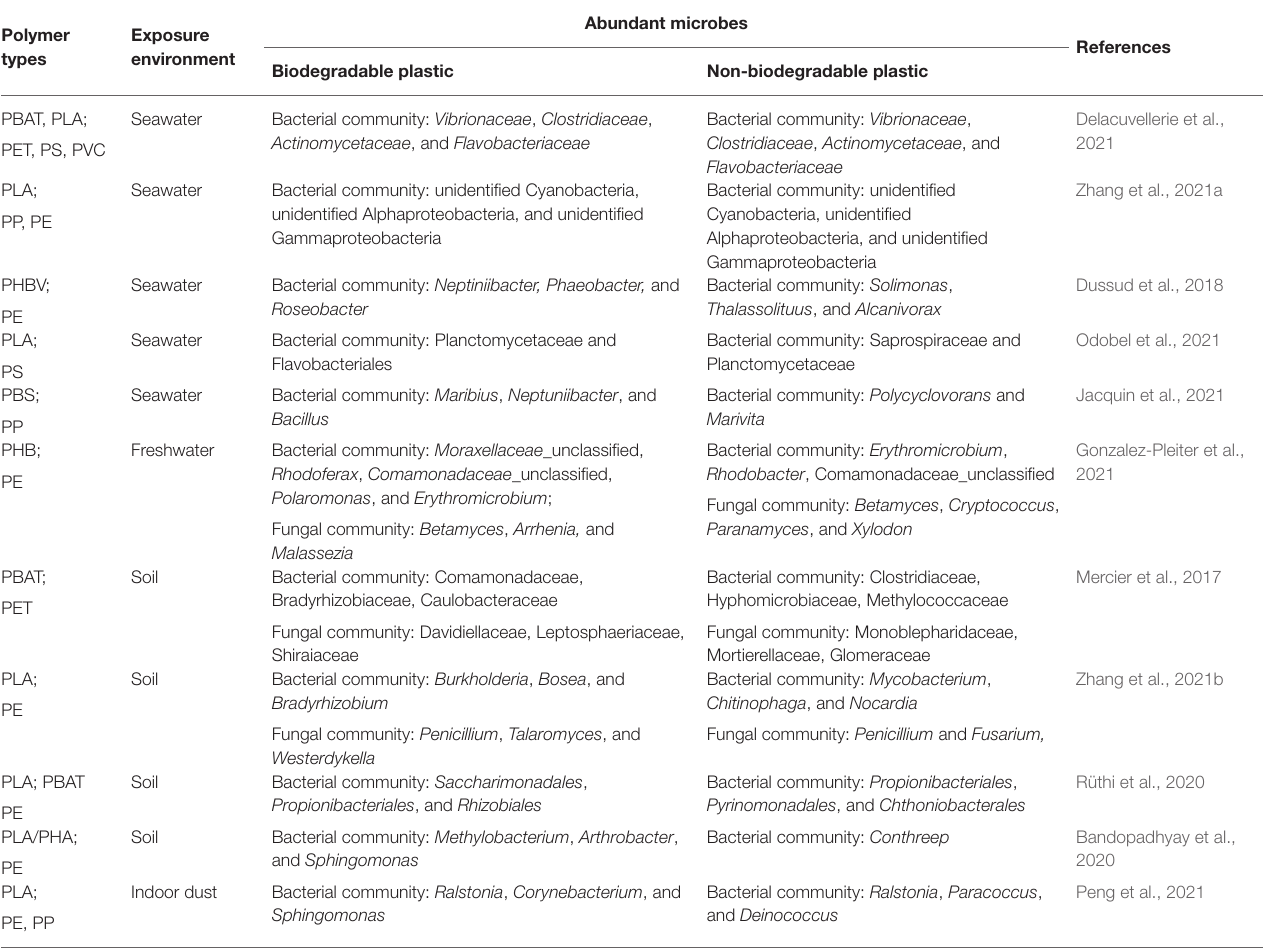
TABLE 1 | The plastisphere compared with biodegradable and non-biodegradable plastics. Polymer